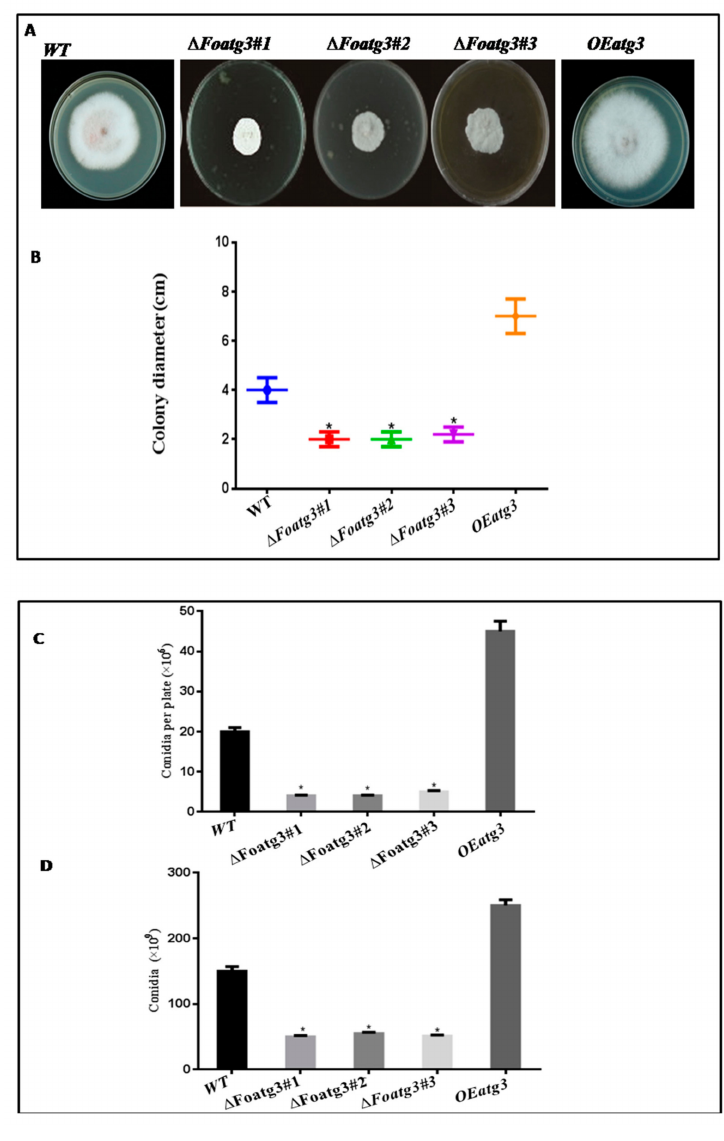
Figure 3. Conidia and hyphal formation were significantly reduced in the Foatg3 mutant. ( A ) Showing fungal colony after 7 days of strain inoculation. ( B ) Graph showing comparative growth of di ff erent fungal strains. Fresh microconidia were inoculated in PDA media and then incubated at 28 ◦ C. The diameter of the fungal colonies was measured daily for 7 days and then plotted. ( C ) Graph showing the number of microconidia grown on PDA medium at 28 ◦ C after 7 days. ( D ) Graph showing the number of microconidia recovered after 2 days at 28 ◦ C. The error bars on the graph indicate the standard error. t -test with a * p value < 0.05 was used for statistical